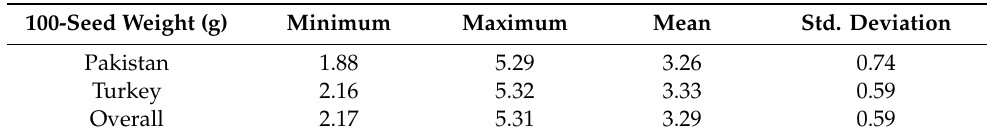
Table 2. Minimum, maximum, mean, and standard deviation (StD) of the 100-seed weight in international safflower panel.